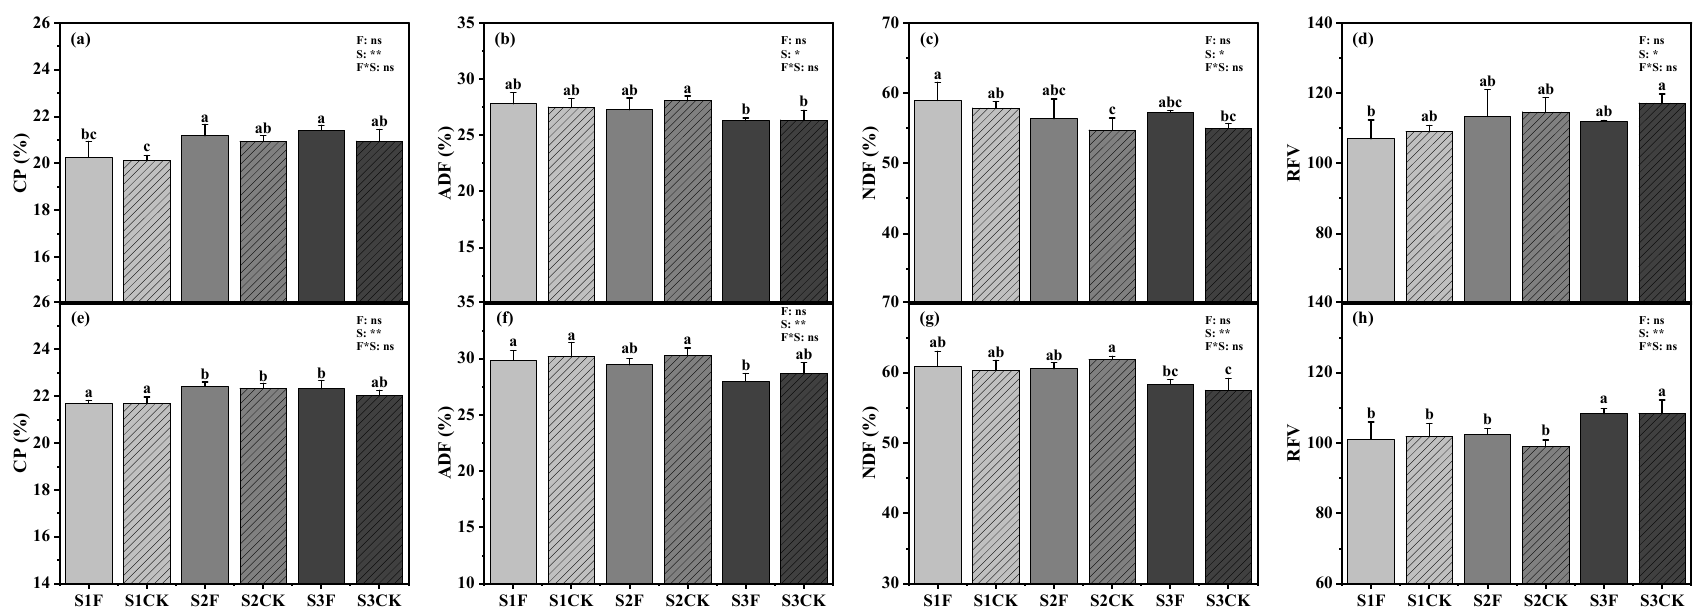
Figure 6. The quality parameters of alfalfa averaged over different cuts for different treatments in 2018 ( a – d ) and 2019 ( e – h ). CP: crud protein; ADF: acid detergent fiber; NDF: neutral detergent fiber; RFV: relative feeding value. The error bars represent the standard deviation, and columns with different letters significantly differed at p < 0.05. F: biosolids fertilizer treatment; S: salinity treatment; F ∗ S: the interaction of biosolids fertilizer and salinity. ns, non-significant; * and ** indicate significances at p < 0.05 and p < 0.01 levels of ANOVA analysis, respectively.